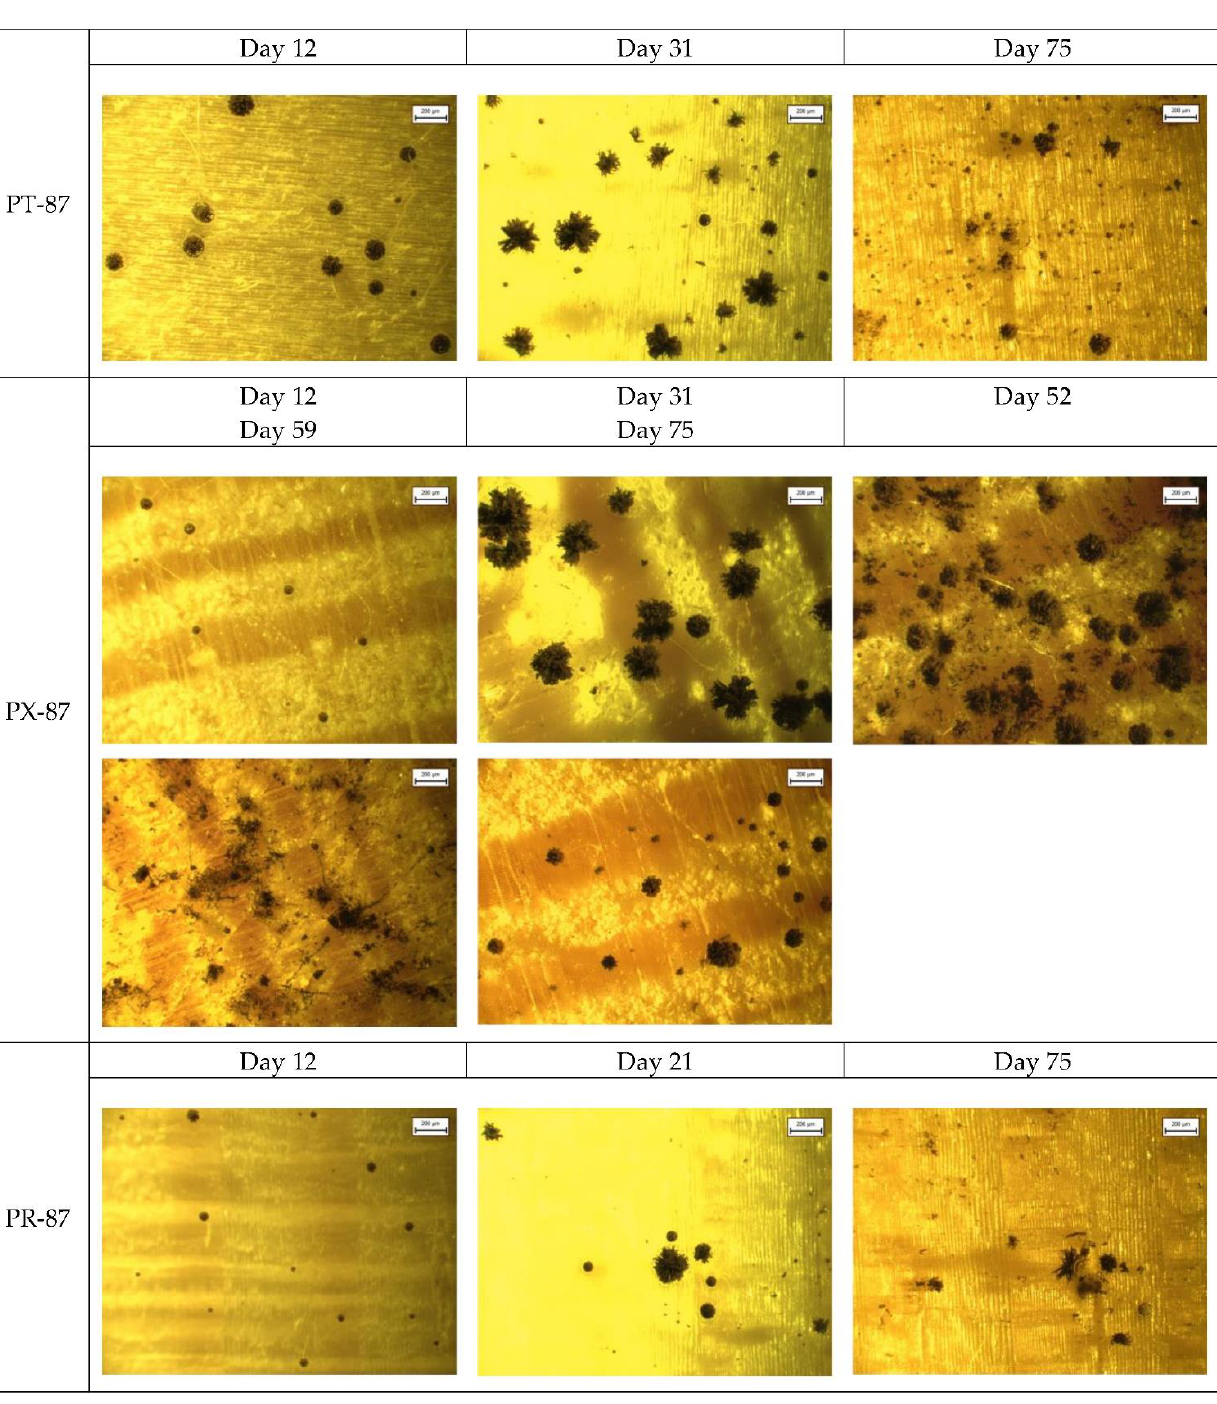
Figure A1. Selected microscopic images for subsets PT-87, PX-87, PR- 87 (bar is 200 μm).